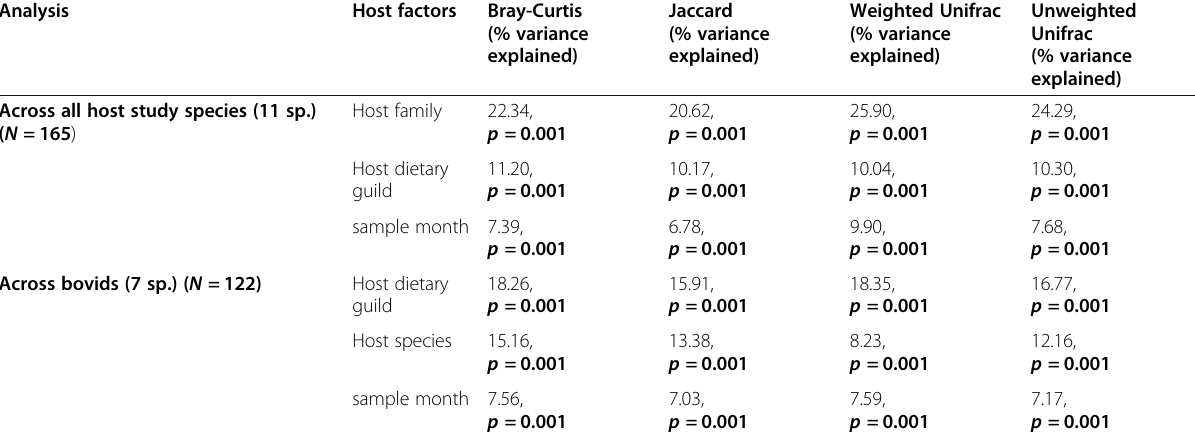
Table 3 Host taxonomy and dietary guild shape the gut microbiotas of African herbivores